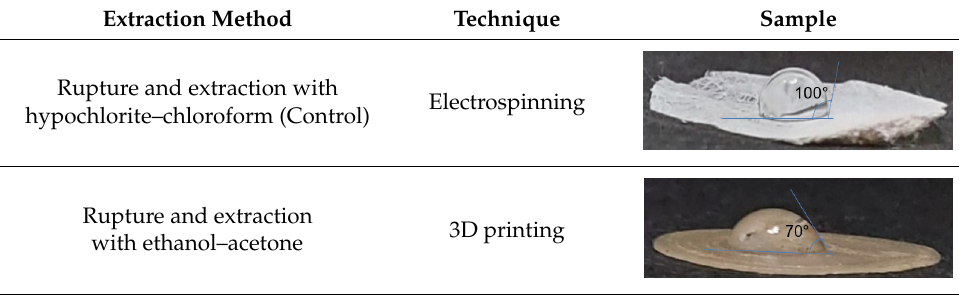
Table 3. The contact angle of the scaffolds.